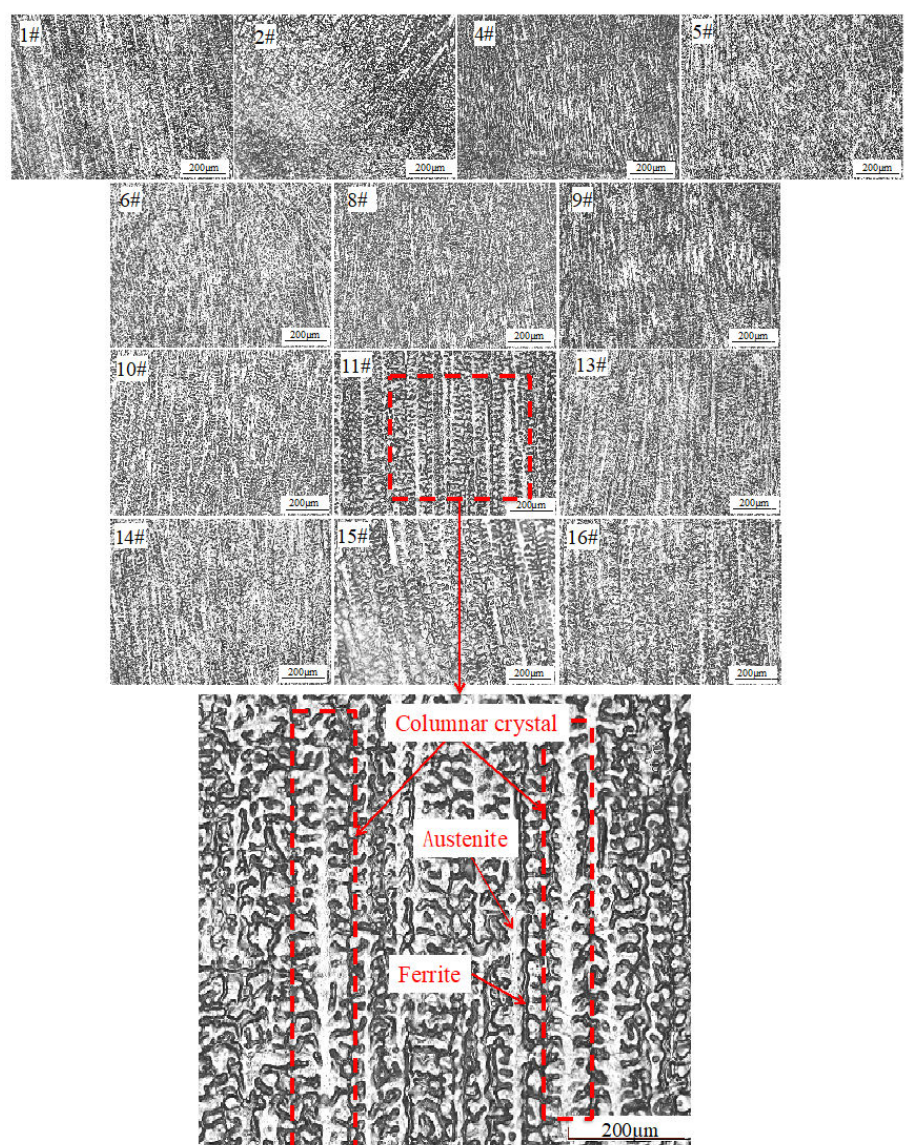
Figure 4. Microstructure of different